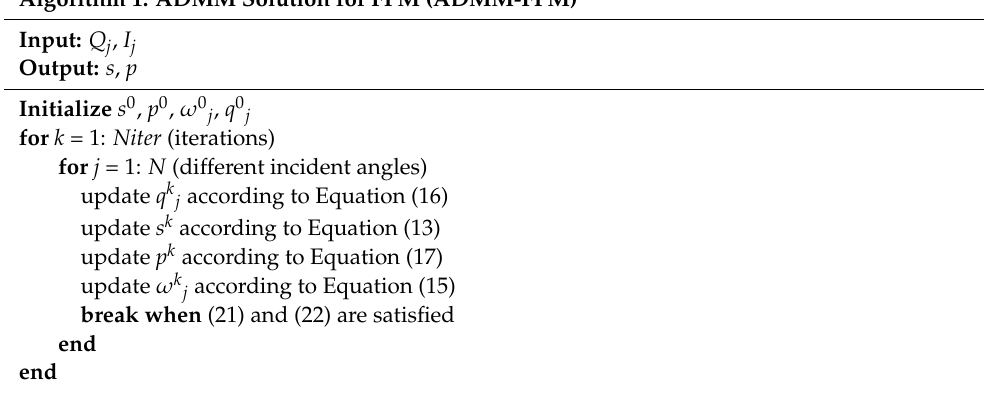
Algorithm 1: ADMM Solution for FPM